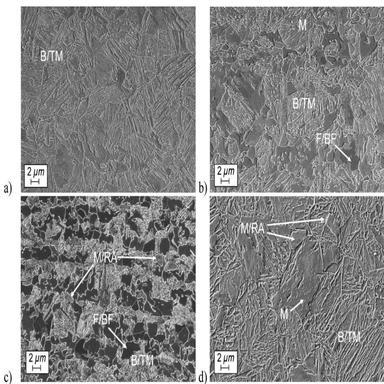
Microstructures of (a) CP (b) DP (c) TBF and (d) Q&P.